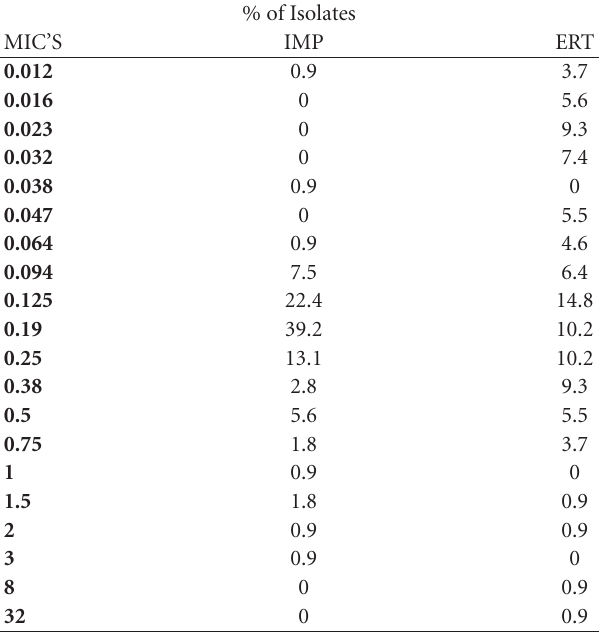
Table 3: Imipenem (IMP) MICs distribution of 03 principals species of ESBL-EB. % of isolates